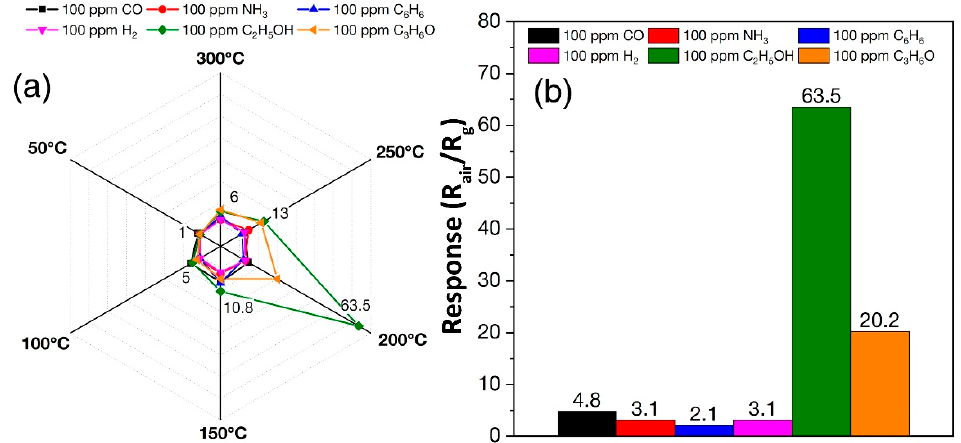
Figure 8. Selectivity diagrams showing the sensor responses of the SnO 2 film to various analytes at operating temperatures of 50–300 ◦ C ( a ) and at 200 ◦ C ( b